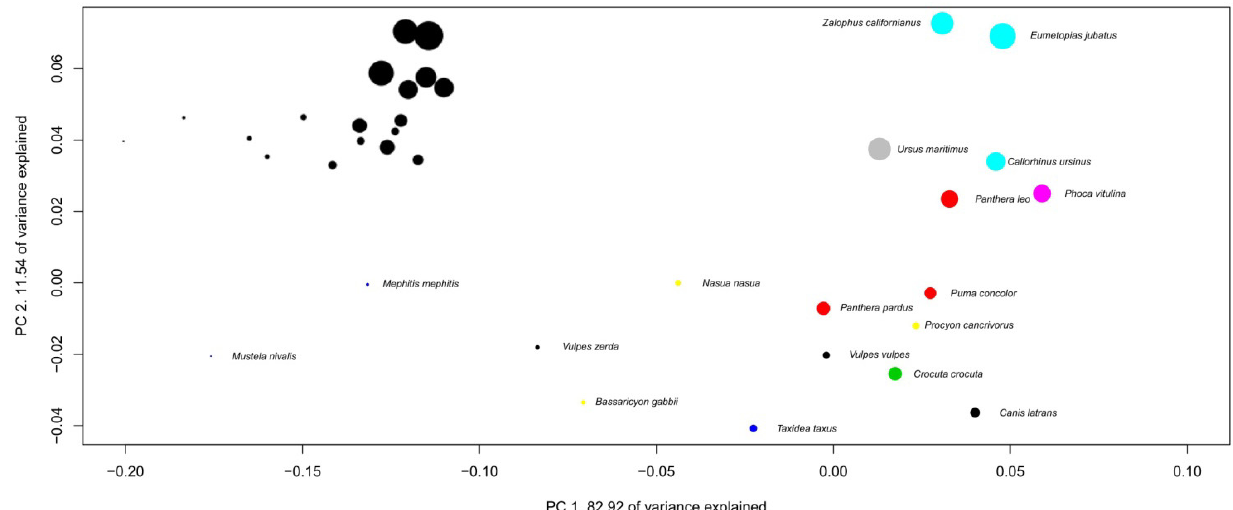
Figure 3. Phylogenetic Principal Component Analysis of carnivores’ brain structure proportions. Regression on independent contrasts of logged absolute brain size onto independent contrasts of position on PC1: Multiple R -squared: 0.791, F -statistic: 60.63 on 1 and 16 DF, P = 7.858 × 10 − 7 ; PC2: Multiple R -squared: 0.077, F -statistic: 1.332 on 1 and 16 DF, P = 0.2654. Families are: black: Canidae, red: Felidae, green: Hyaenidae, dark blue: Mustelidae, light blue: Otariidae, purple: Phocidae, yellow: Procyonidae, grey: Ursidae.